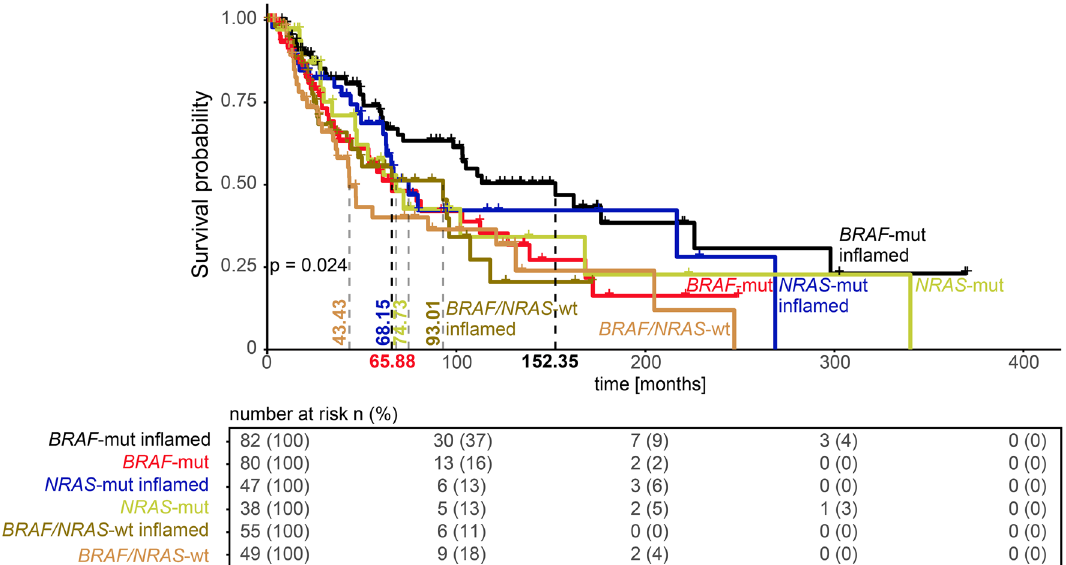
Figure 3. Prognostic value of TIL clusters within molecular subtypes of malignant melanomas. Kaplan–Meier curve of TCGA MM patients (n = 351) stratified for mutational subtypes ( BRAF- mutated, NRAS -mutated, and BRAF/NRAS wildtype). Inflamed tumors are indicated according to their molecular subtype, while inflamed tumors are defined as tumors with TIL clusters above the median value as a cutoff. The median survival time for each molecular subtype and inflammatory status is provided using a vertical line and indicated in letters according to their color code. The risk table is shown below for the given